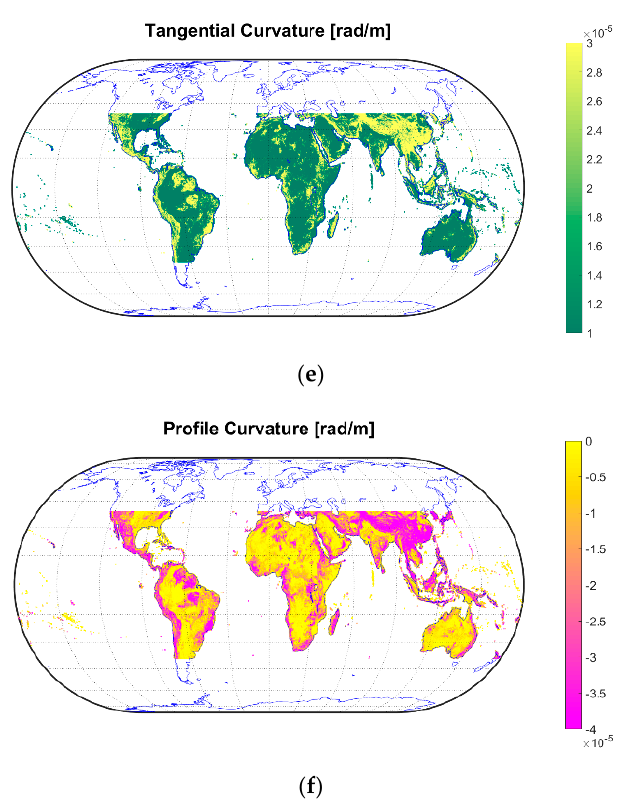
Figure 2. Global Multi-resolution Terrain Elevation Data 2010 ( GMTED2010) model-based topographic parameters. ( a ) Topographic position index ( TPI ) (m), ( b ) terrain ruggedness index ( TRI ) (m), ( c ) vector ruggedness measure ( VRM ) (deg), ( d ) Slope β (deg), ( e ) tangential curvature ( TC ) (rad/m), and ( f ) profile curvature ( PC ) (rad/m). Parameters were displayed over the Cyclone Global Navigation Satellite System ( CyGNSS) coverage over land surfaces.